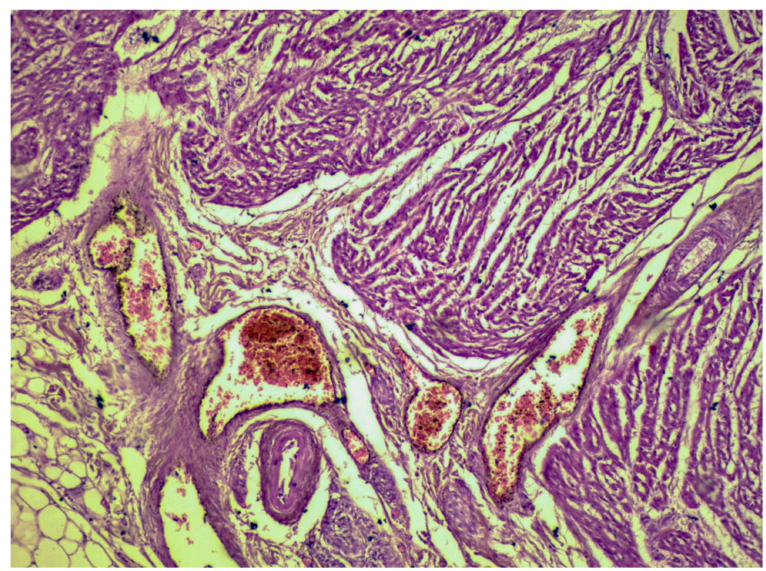
Figure 7. 400 × HE stain of fetal cardiac tissue demonstrating microthrombosis.